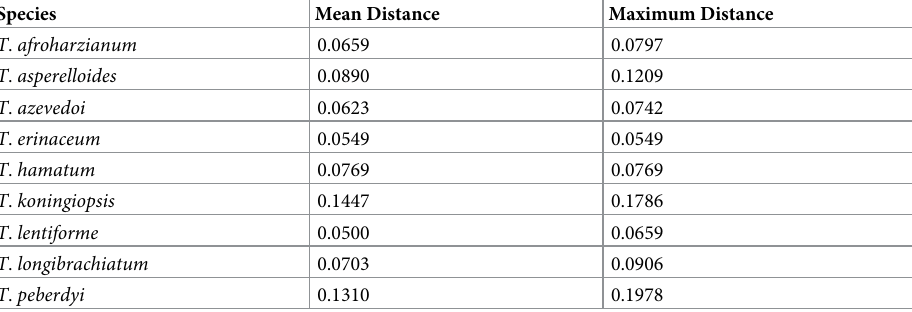
Table 5. Intraspecific genetic distances based on ALFPs.